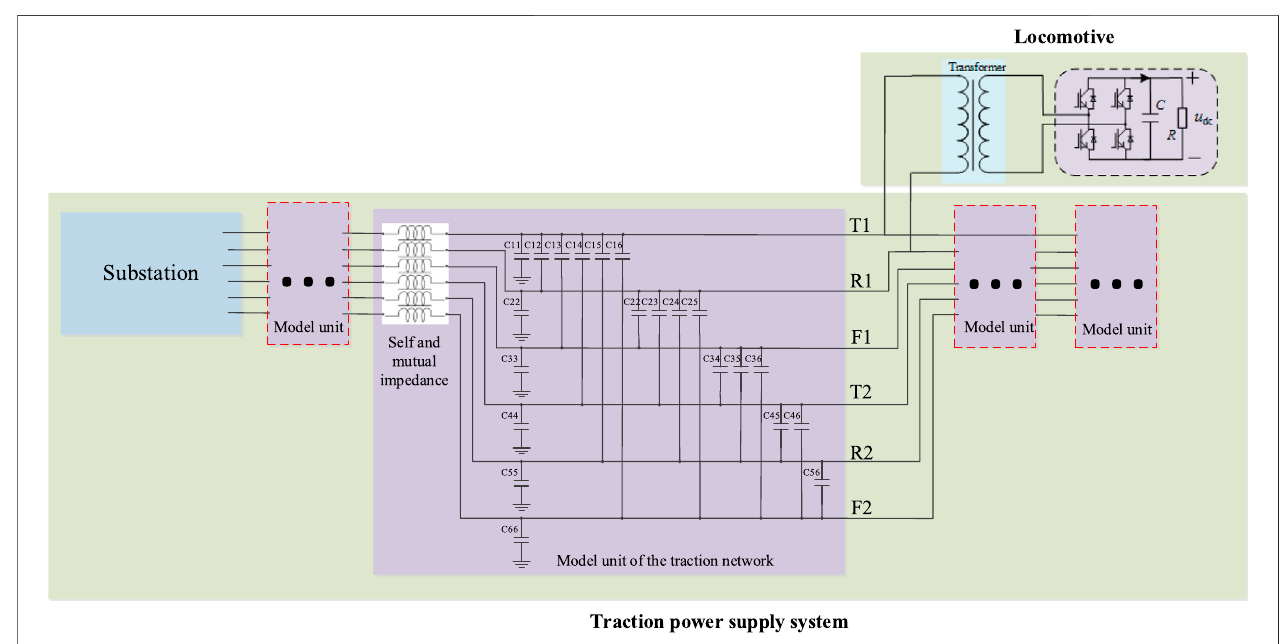
FIGURE A1 | The illustration of the L-N system simulation model.